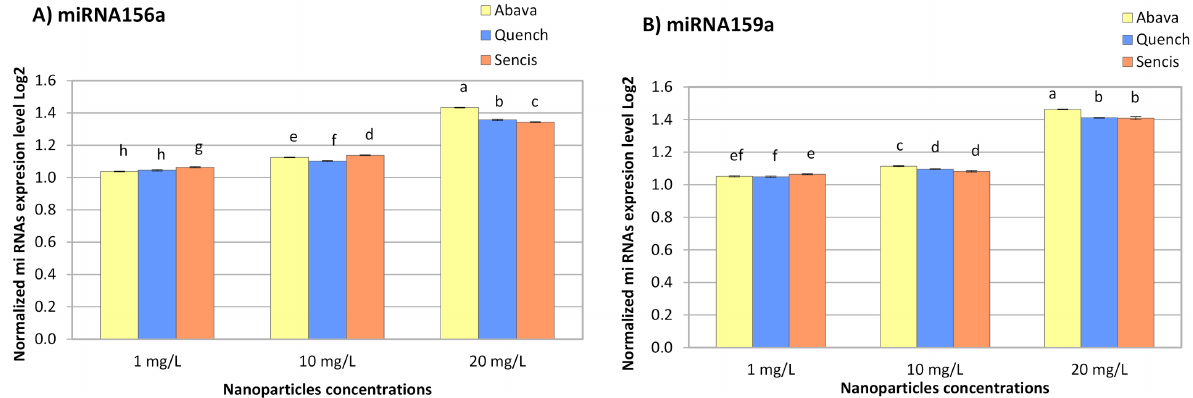
Figure 6. The results of the determination of miR156a ( A ), miR159a ( B ), expression levels in control and experimental groups of three H. vulgare L. cultivars (plants exposed to different concentrations of Fe 3 O 4 nanoparticles). Values are the mean of three replicates with SD. Different letters within each bar indicate significant differences at p < 0.05 and the same letters indicate no significant difference (Tukey’s test—two-way analysis of